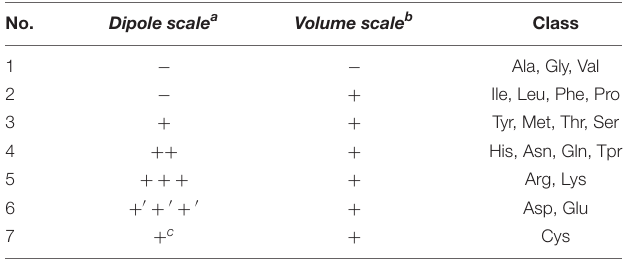
TABLE 1 | Classification of amino